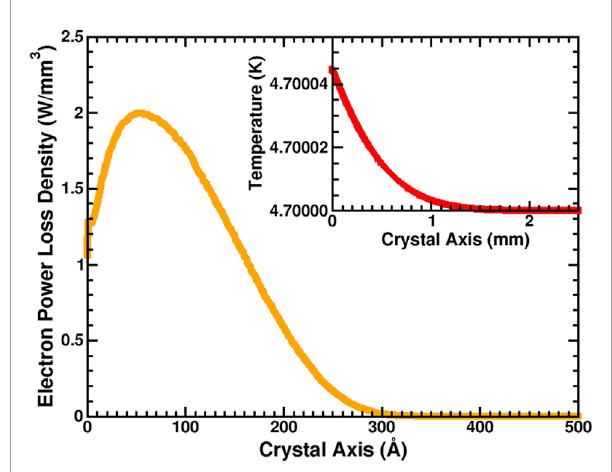
FIGURE 8 Calculated electron power loss density, S ( z ) (solid orange line), and (top right corner) temperature distribution (solid red line) along crystal